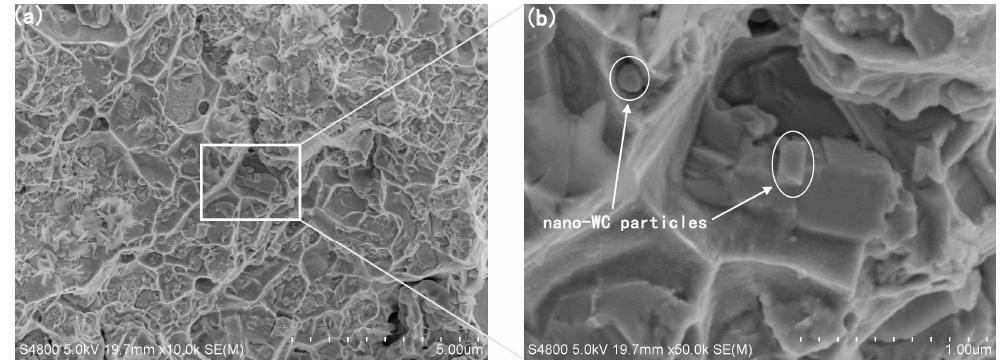
Figure 4. The fracture morphologies of sample: ( a , b ) S5.